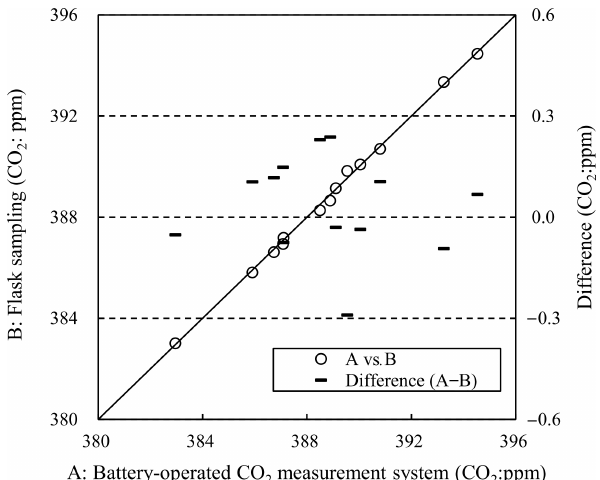
Figure 7. Comparison between CO 2 concentrations measured by the battery-operated CO 2 measurement system and in the flask- sampling experiment, and the difference in CO 2 concentration be- tween both